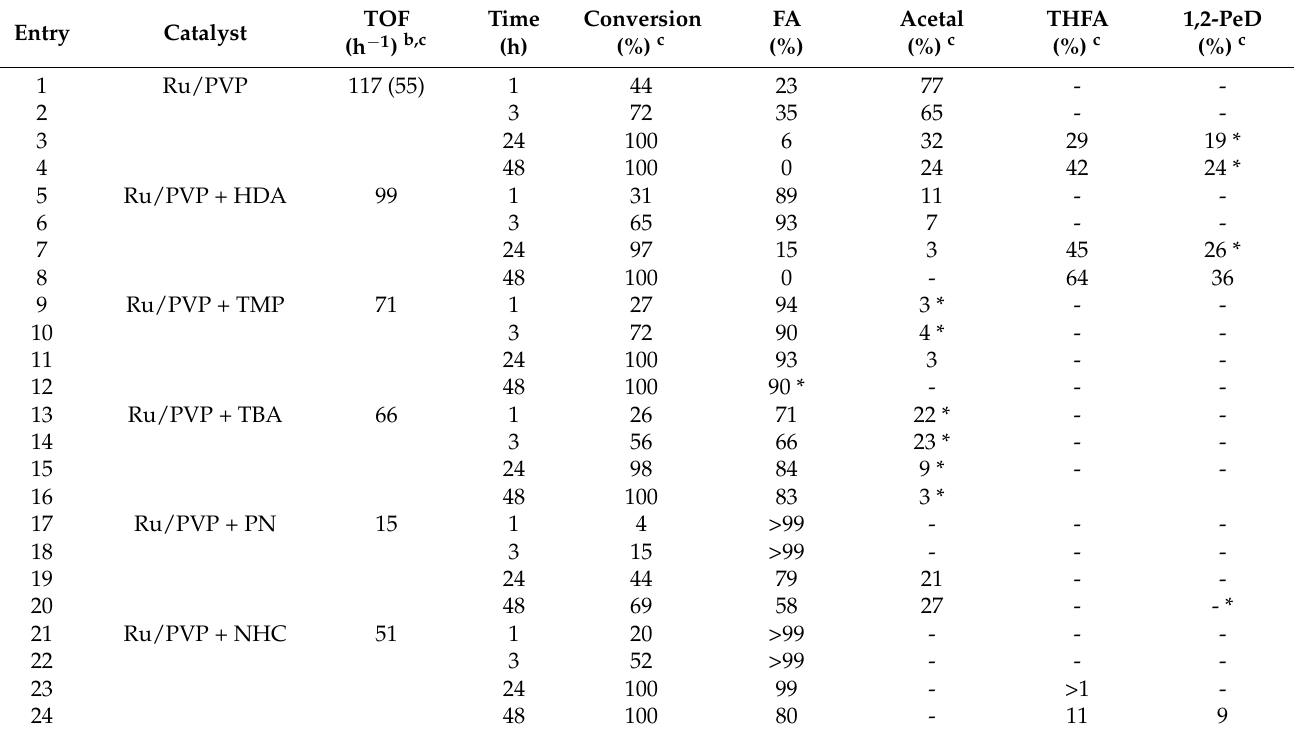
a Reaction conditions: 2 × 10 − 2 mmol of metal, 4 mmol of furfural, 0.5 mmol of dodecane (internal standard), 20 bar of